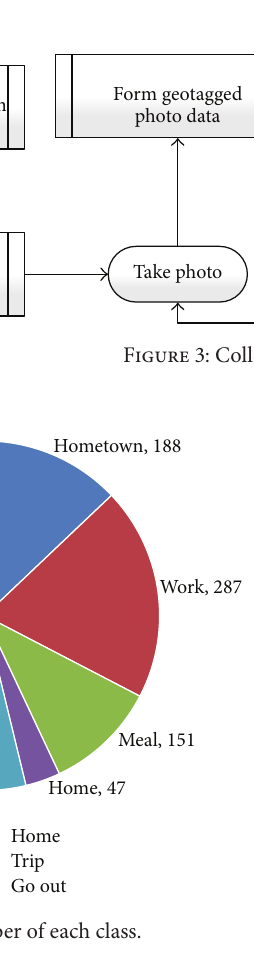
Figure 4: Number of each class.